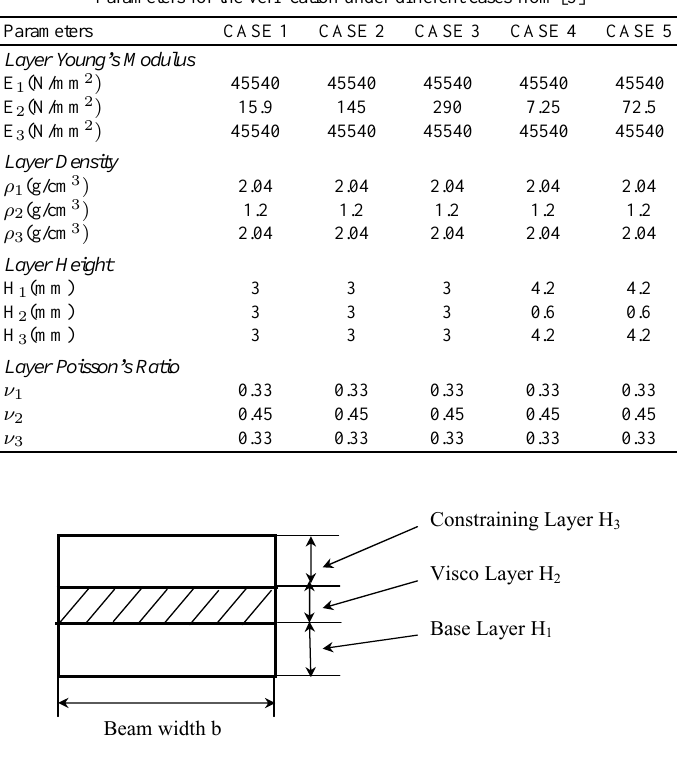
Fig. 6. Cross-section of the composite